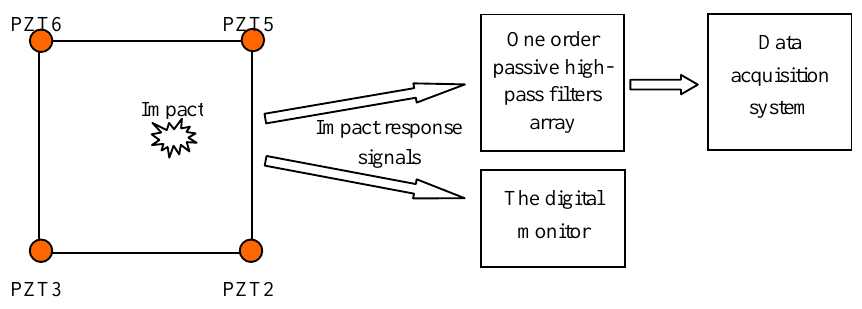
Figure 4. Experimental setup of impact response signal acquiring.